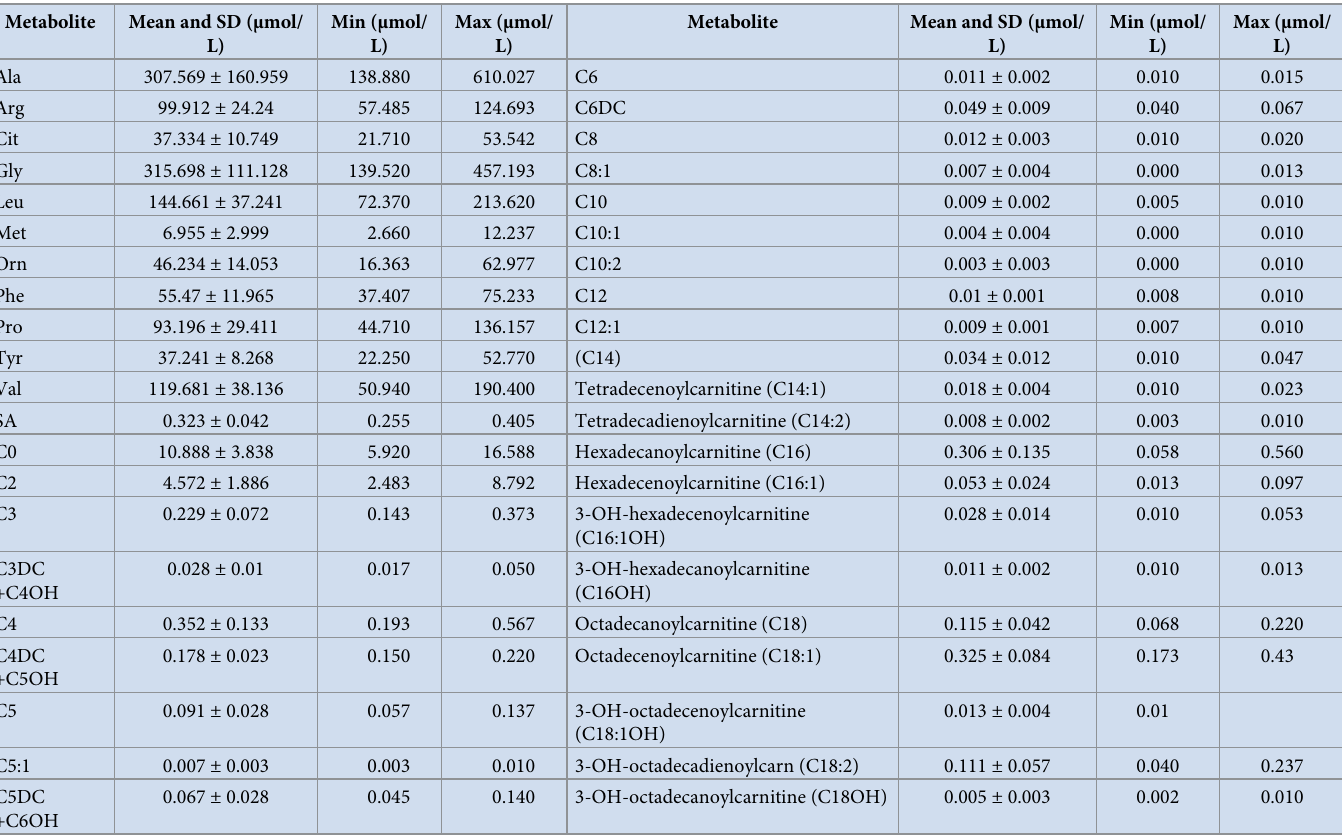
Table 1. Amino acid and acylcarnitine levels determined in blood samples of free-ranging U . americanus Pallas, 1780. The column on the left lists the abbreviations of the metabolites analyzed. Mean, standard deviation (SD) and range (minimum and maximum) are shown. Metabolite Mean and SD ( μ mol/